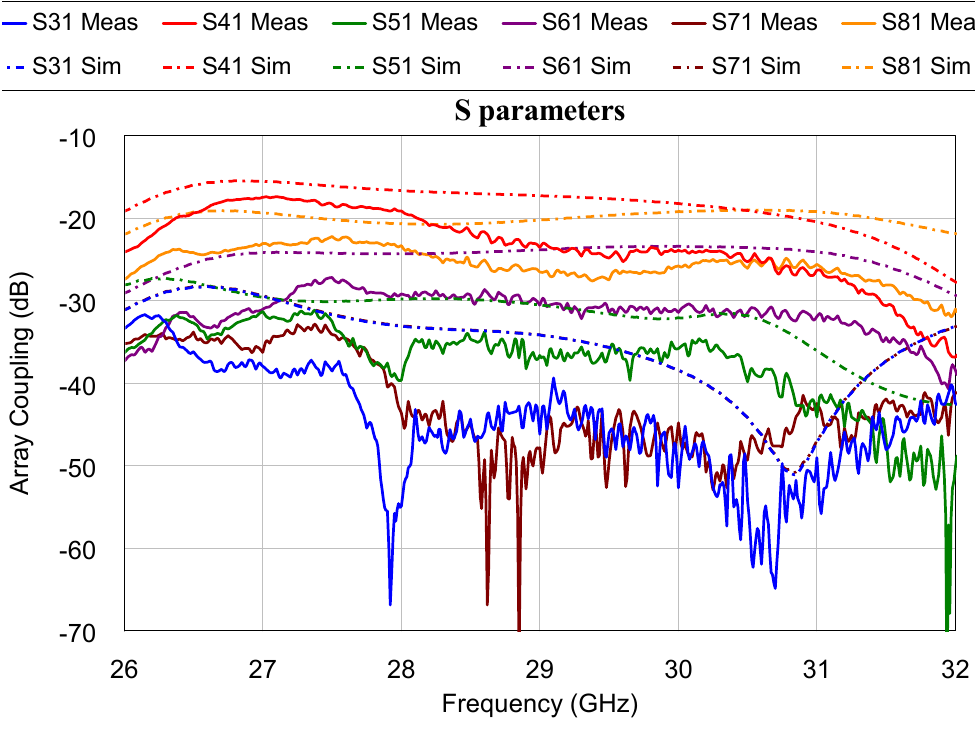
Figure 9. Mutual coupling results.